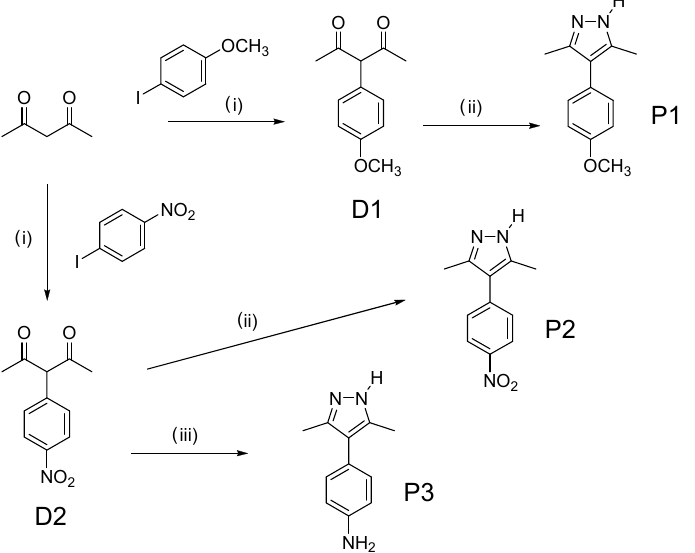
Scheme 1. Synthetic routes for the preparation of the final pyrazole compounds: (i) (1) CuI,